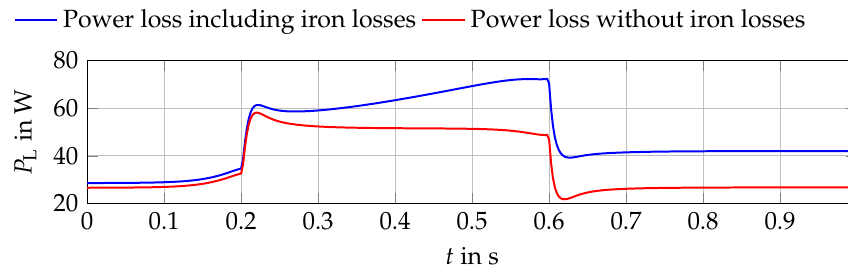
Figure 13. Simulation of power losses including iron losses and without iron